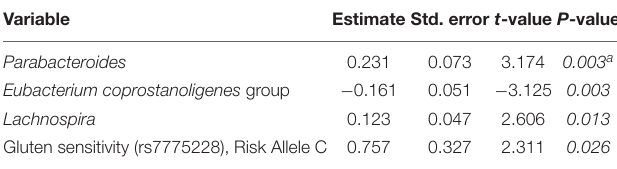
TABLE 7 | Reduction in constipation symptom severity linear model: demographics + genomics + microbiome (D + G + M). Variable Estimate Std. error t -value P -value